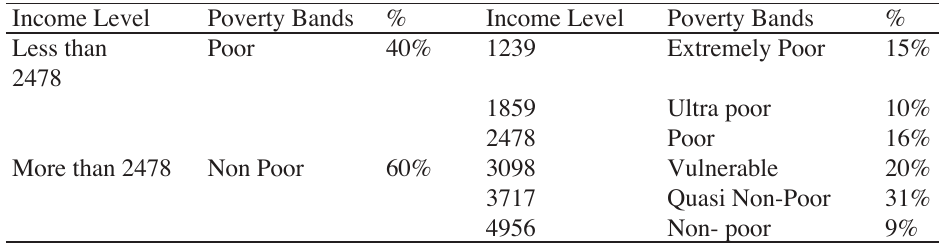
Magnitude of Poverty in Atthara Hazari Sub